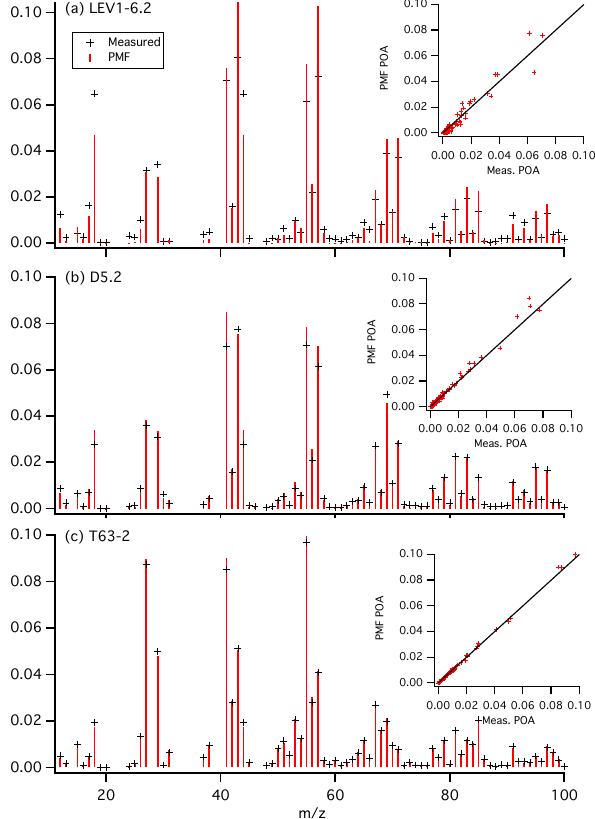
Figure 7. Comparisons of the mass spectra of PMF-derived POA factors (red sticks) to direct measurements of POA conducted prior to photooxidation (symbols) up to m/z 100. Insets show scatter plots of the mass spectra, and the black line is the 1 : 1 line. Com- parisons are presented for experiments LEV1-6.2 (a) , D5.2 (b) , and T63-2 (c)